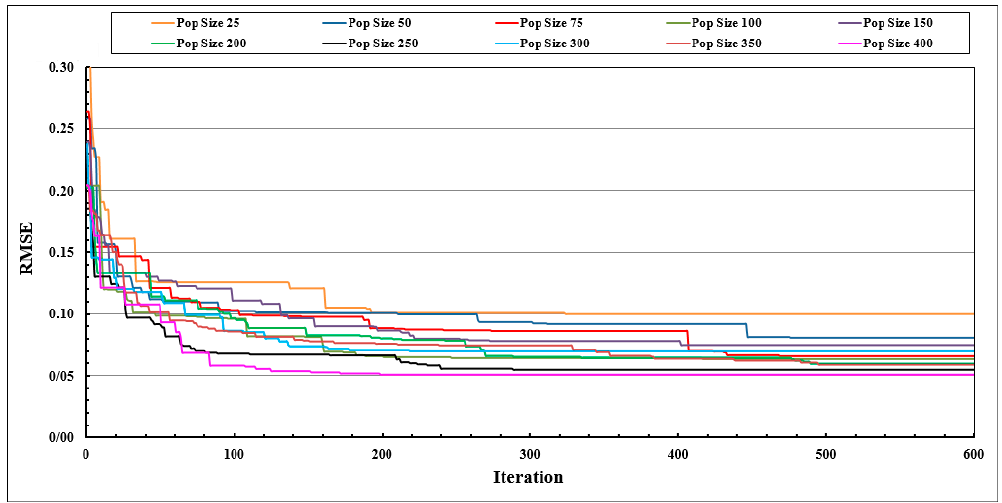
Figure 9. ICA-ANN models with different population sizes.